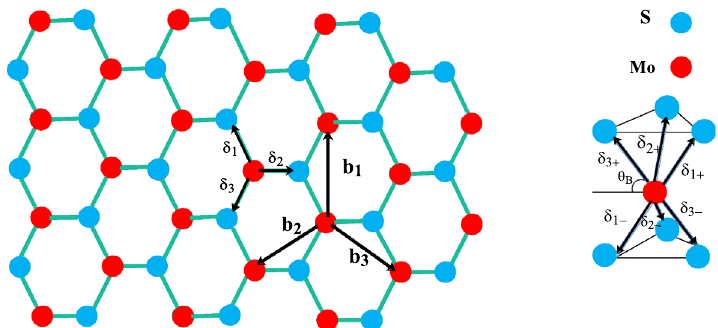
Figure 1. Left panel: A top view schematic of single layer MoS 2 lattice structure. Blue(red) circles indicate Mo(S) atoms. b i 1,2,3 show the vectors connecting next nearest neighbor lattice sites while δ i = connecting nearest neighbor lattice sites. Right panel: Side view of the lattice structure are seen where Mo atom is surrounded by six S